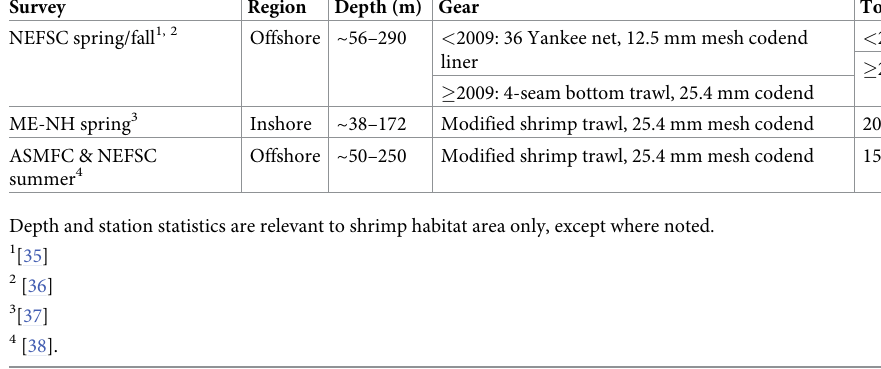
PLOS ONE | https://doi.org/10.1371/journal.pone.0253914 July 21,